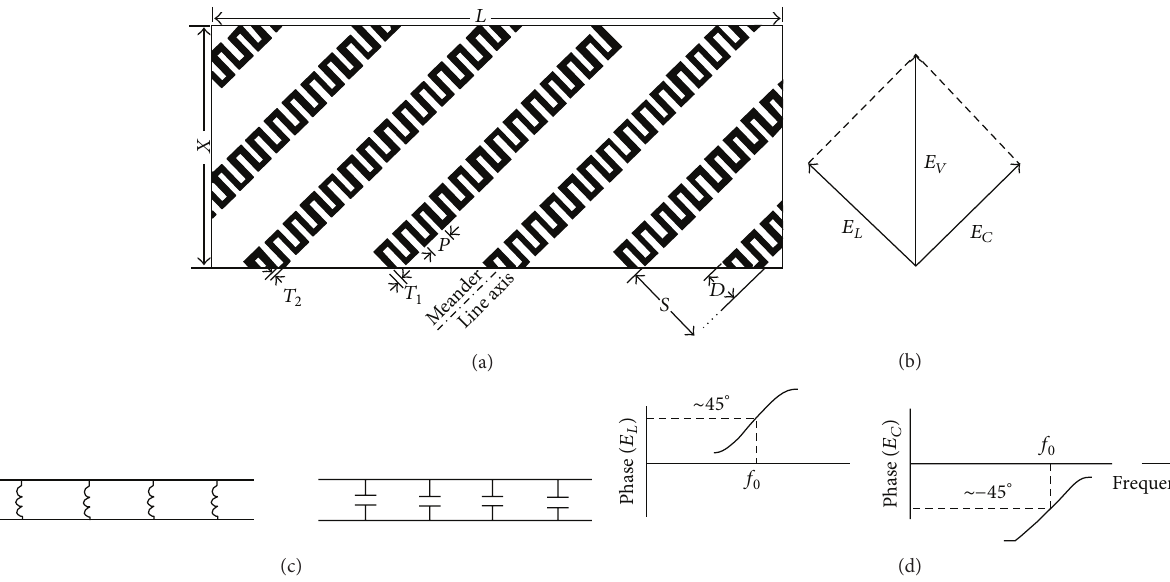
Figure 7: (a) Schematic of the anisotropic polarizer based on meander lines. (b) Decomposition of the incident fields along the two main axes. (c) Equivalent circuits for the two polarized waves. (d) Phase shifts for the two orthogonal polarization types. Figures are reproduced from